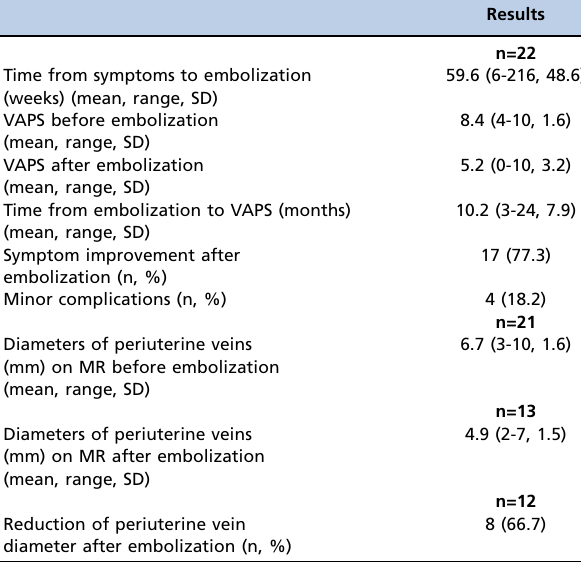
Table 2 - Clinical and procedural